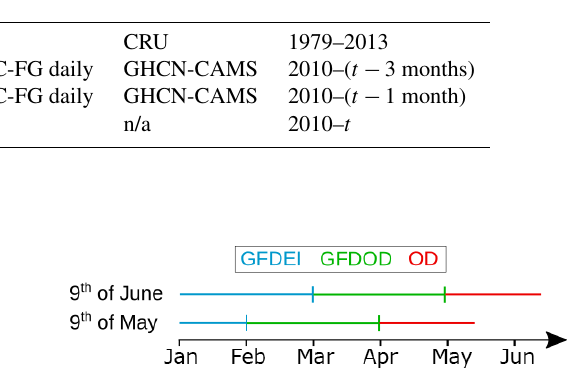
Figure 1. Schematic of the updating procedure. The HydroGFD data are continuously updated with GFDEI as long as EI data are available. The intermediary data set GFDOD fills up the time series as long as GPCC data are available and then continues with uncor- rected OD data. Because the previous month becomes updated on the 10th of each month, the 9th is the day with the longest period of OD driving data. The next month, GFDEI is extended 1 month, and the GFDOD data are updated for the new